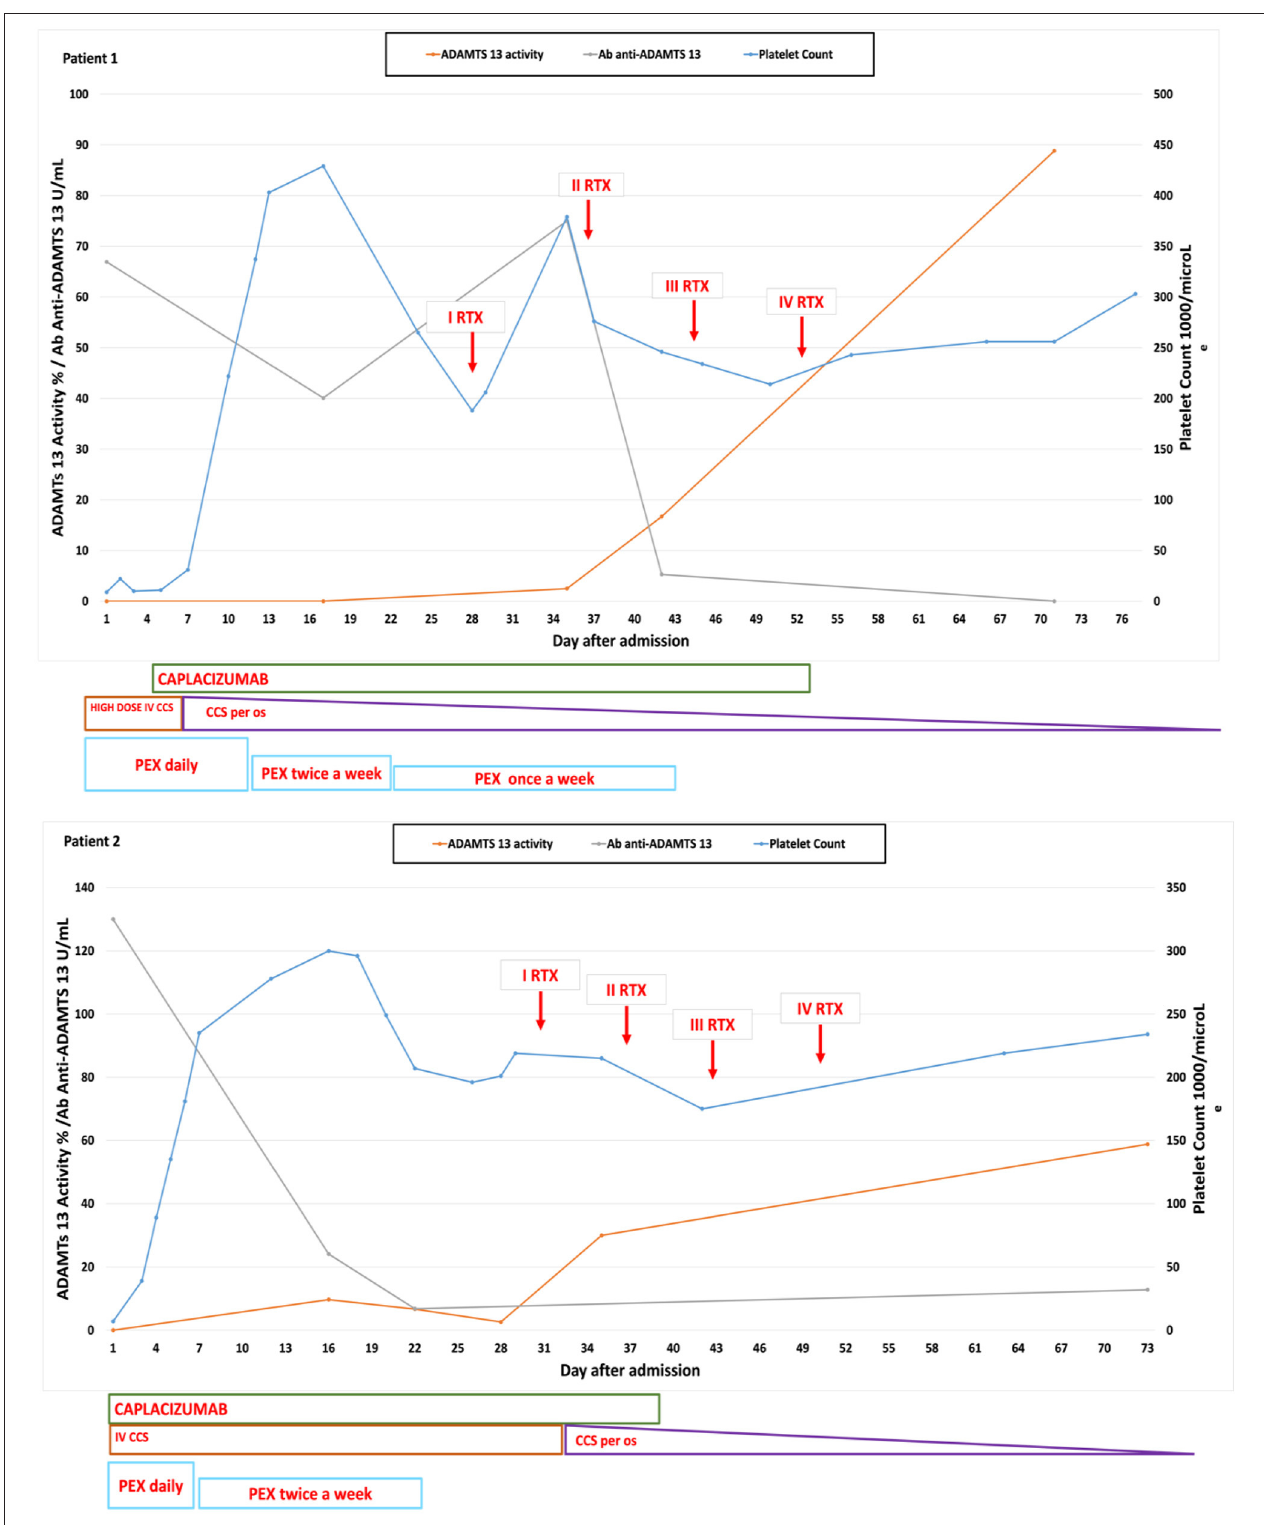
FIGURE 1 | Graphs showing the platelet count, ADAMTS13 activity, and the anti-ADAMTS13 antibody trend correlated with the administered therapies in our two cases.